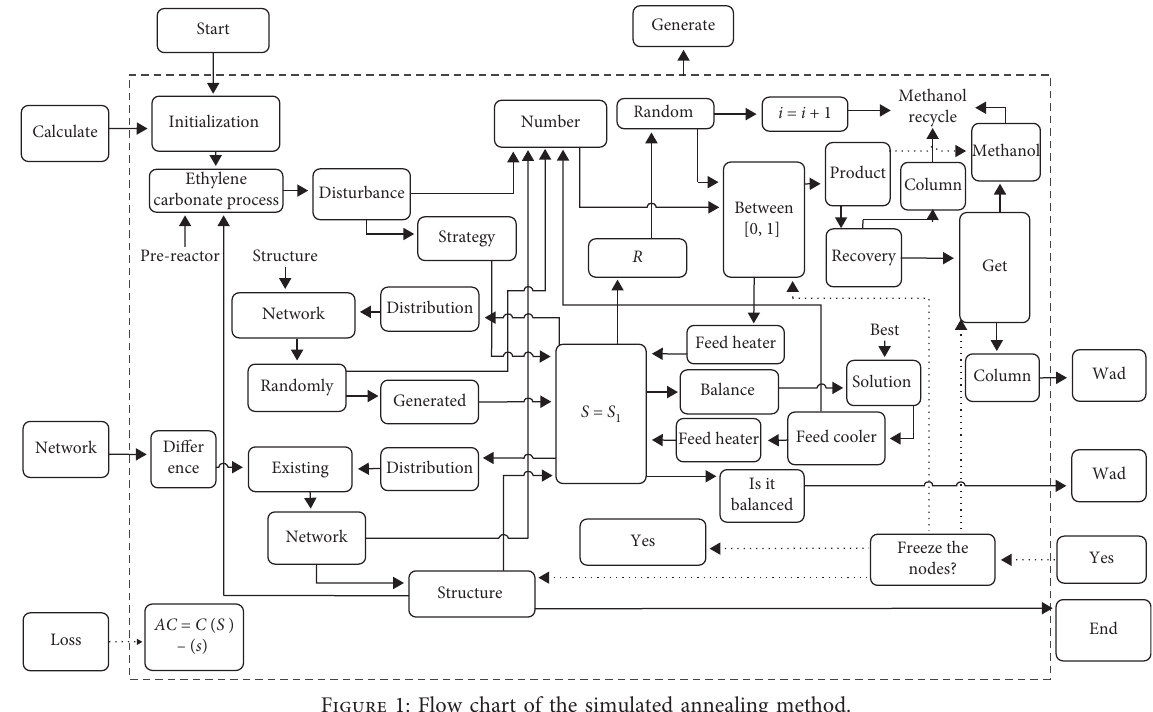
Figure 1: Flow chart of the simulated annealing method.